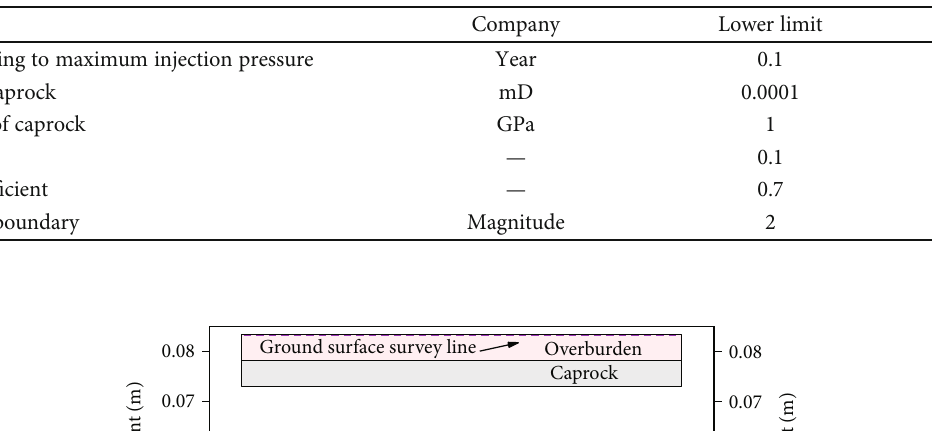
Table 8: Upper and lower limits of sensitivity analysis